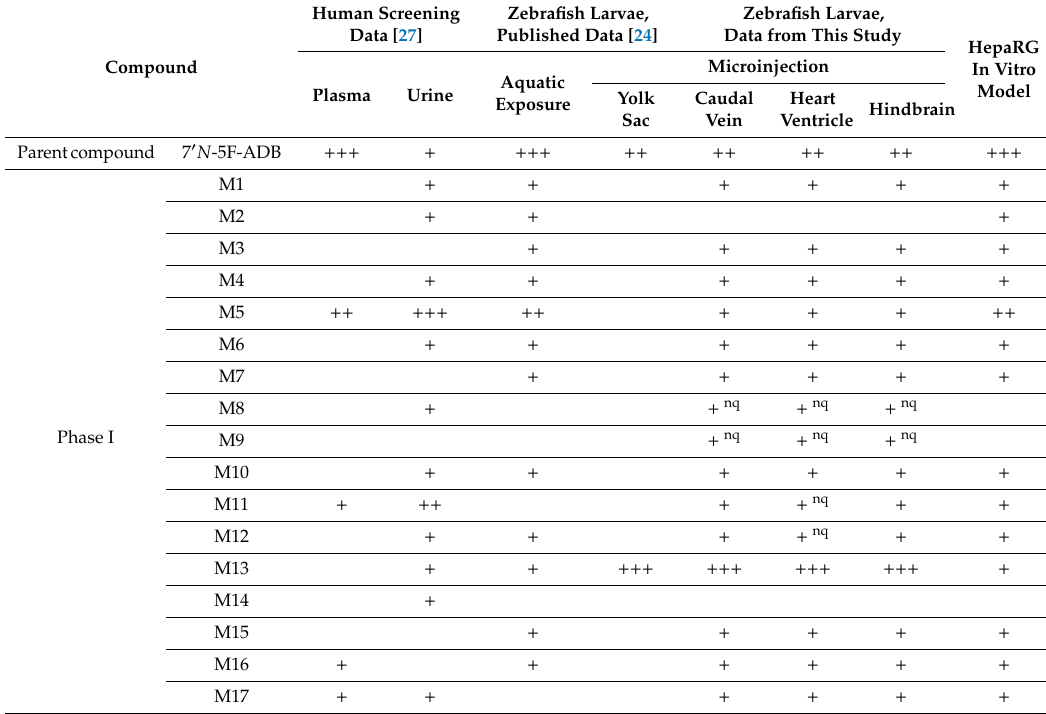
Table 1. Summary of 7′ N -5F-ADB and its phase I and II metabolites and their detection in the different models.